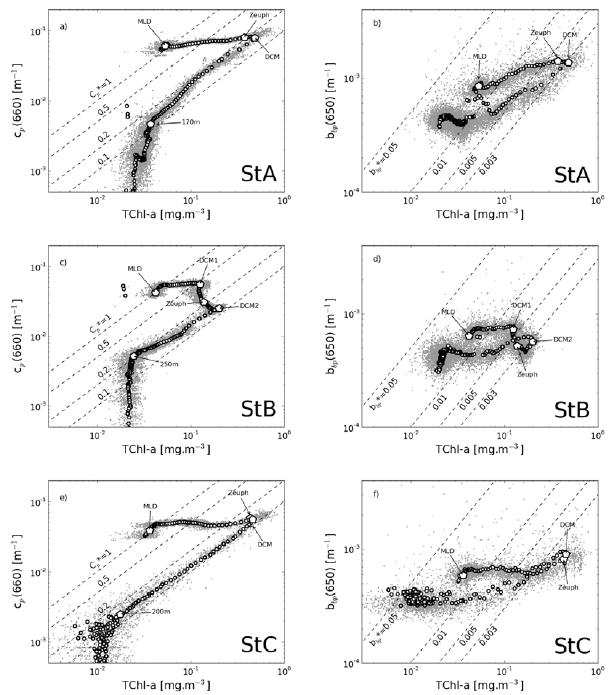
Figure 3. Fig. 3. Vertical profiles of the particulate attenuation coefficient at Fig. 4. c p (660) (left panels) and b bp (650) (right panels) as a func- Figure 4. 660nm, c p (660), for the LD stations A (a) , B (c) , and C (e) . Ver- tion of TChl- a through the whole water column at stations A, B, tical profiles of the particulate backscattering coefficient at 650nm, and C as indicated. The lines drawn with a 1:1 slope correspond to b bp (650), for the LD stations A (b) , B (d) , and C (f) . The depth values of the specific particulate attenuation, c p *(= c p /TChl- a ), and of the euphotic zone, Zeu, and the lower limit of the mixed layer, backscattering, b bp *(= b bp /TChl- a ), coefficients in m 2 (mgTChl- MLD, are indicated. a ) − 1 . The depths of the euphotic zone, Zeu, of the lower limit of the mixed layer, MLD, and of the deep chlorophyll maximum, DCM, are indicated. The numerical depth values (e.g. 170, 250, and 200m) indicate the depth, deeper than the DCM, from which the Log( c p (660)) vs. Log(TChl- a ) relationship departs from linear-